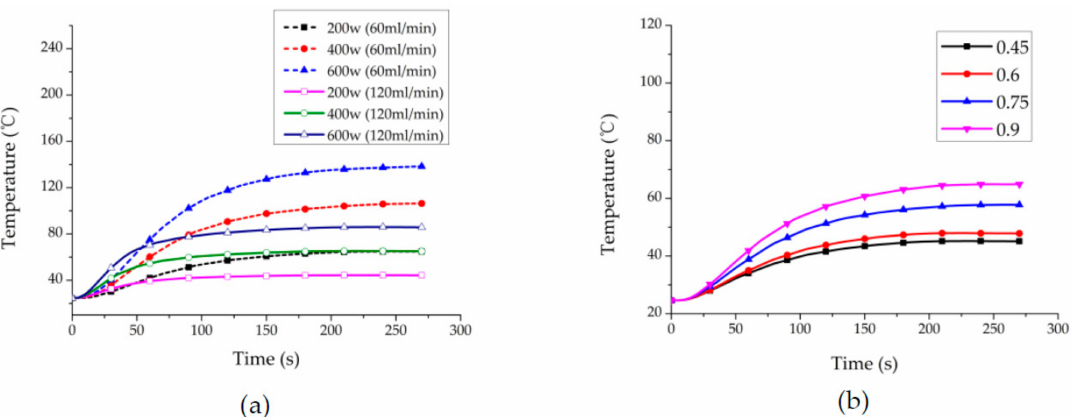
Figure 12. Temperature increase of oleic acid using silicon nitride under different conditions: ( a ) at different power and velocity; and ( b ) at different